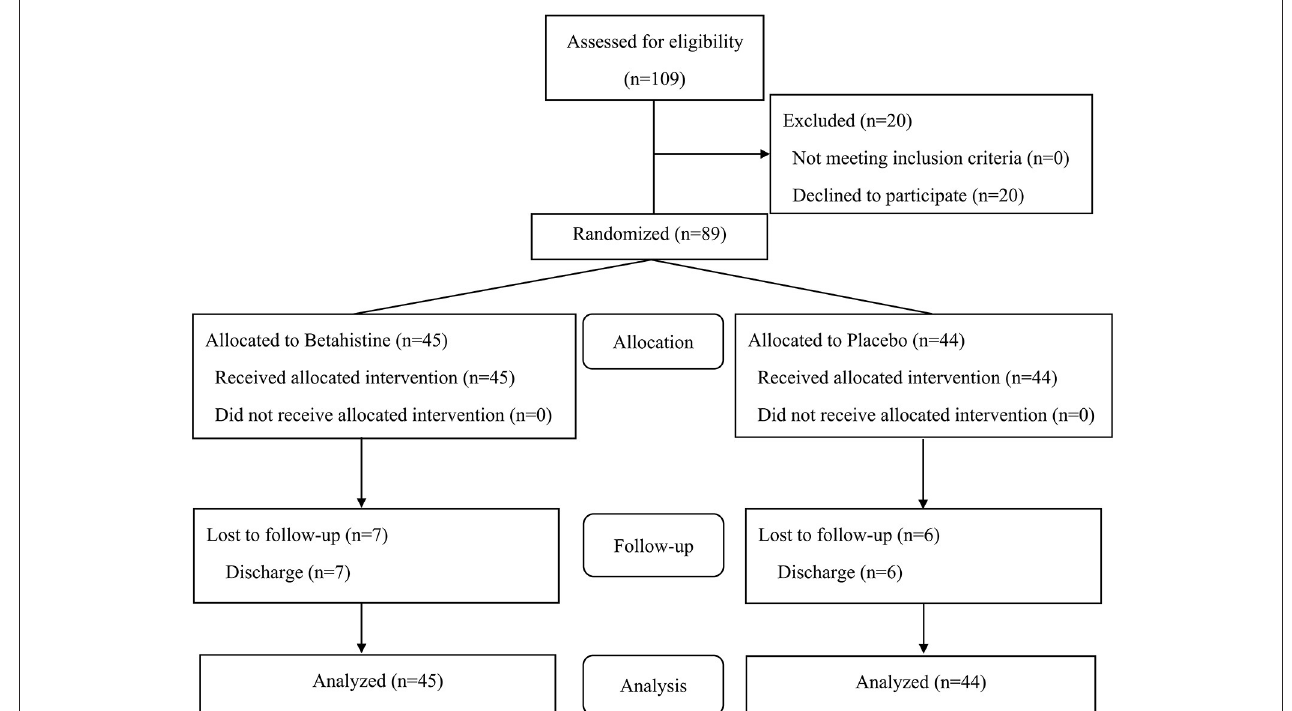
FIGURE 1 | CONSORT flow chart for the present